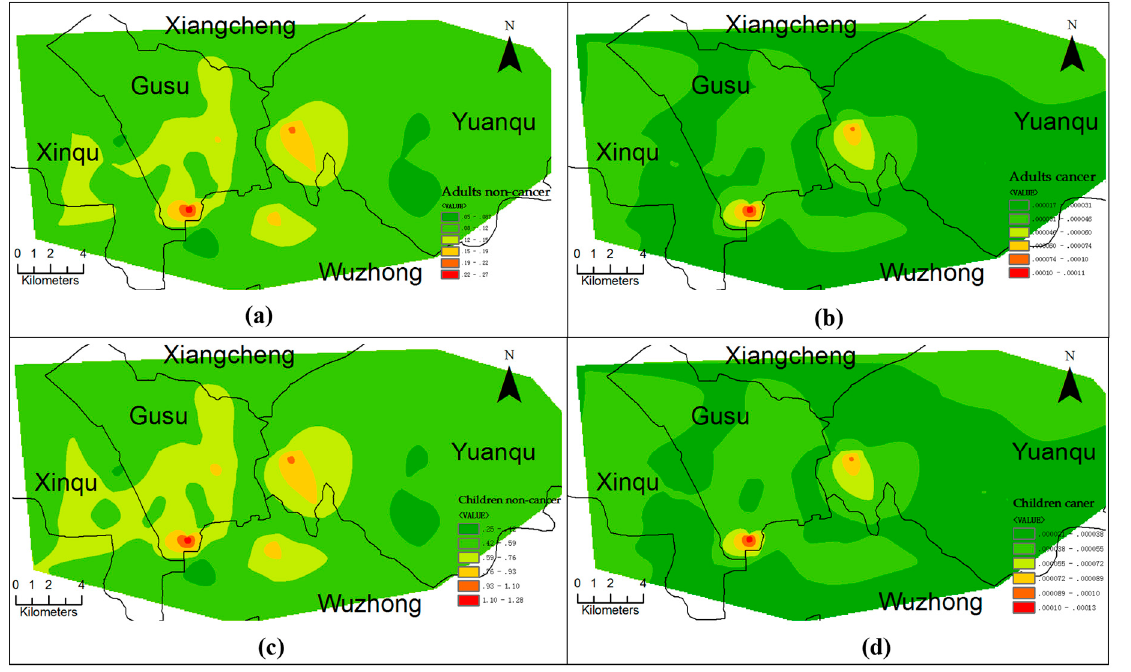
Figure 6. Spatial distribution of Hazard indices (HIs) and total carcinogenic risks (TCRs) for adults ( a and b , respectively) and children ( c and d , respectively).